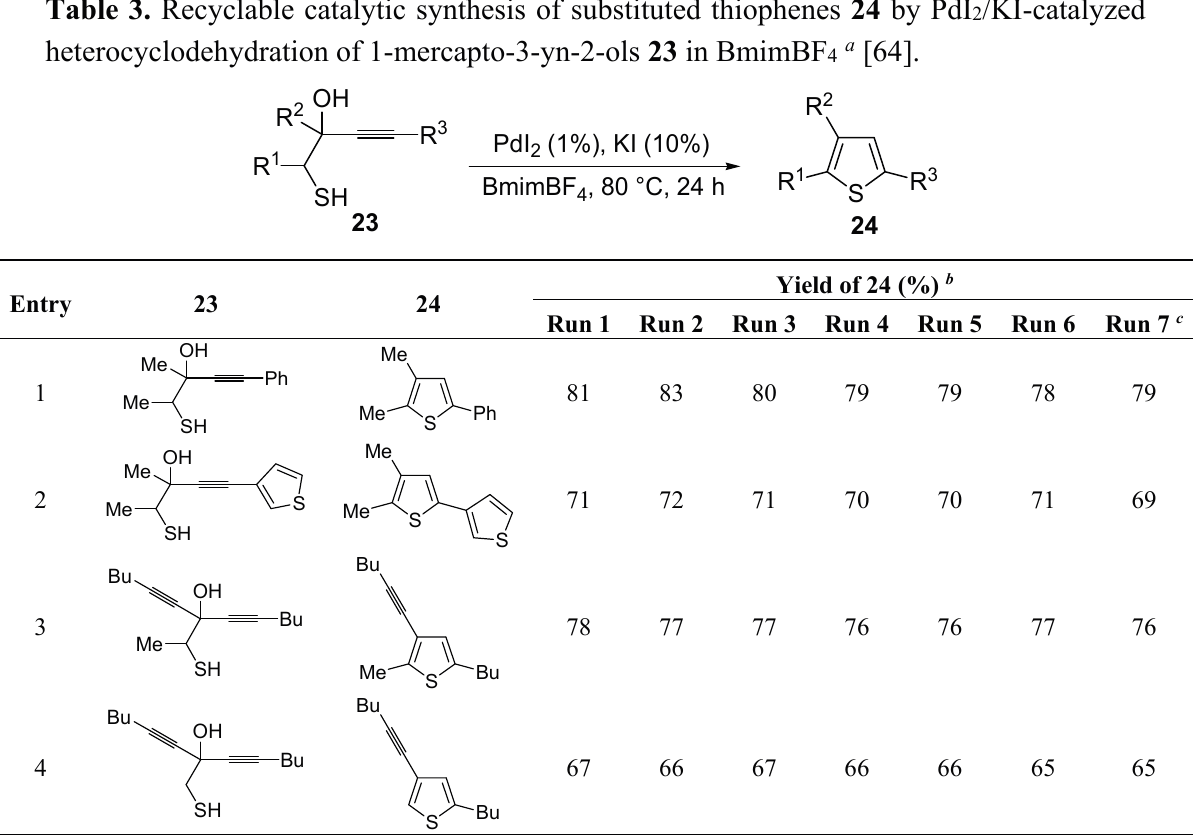
Table 3. Recyclable catalytic synthesis of substituted thiophenes 24 by PdI 2